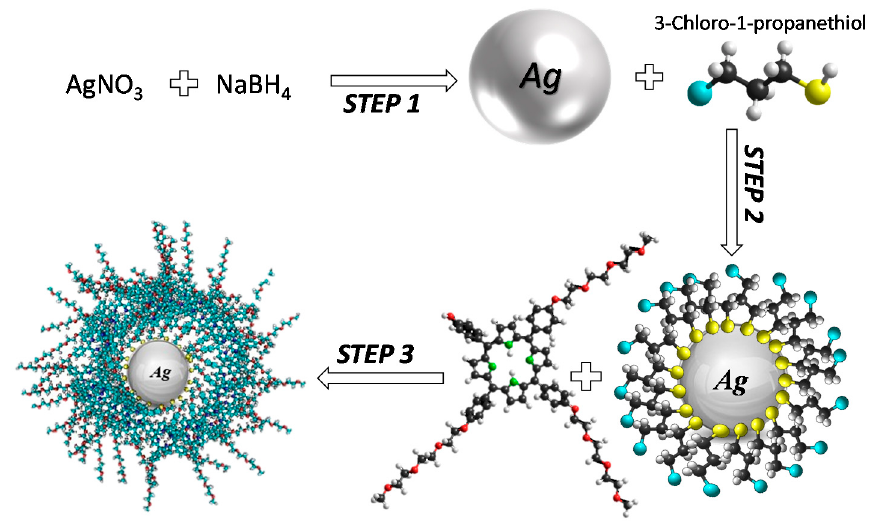
350 400 450 500 550 600 650 700 750